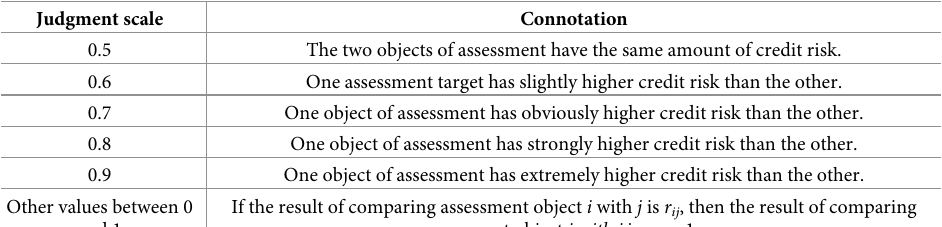
Table 2. Connotations of the fuzzy judgment of credit risk based on a scale of